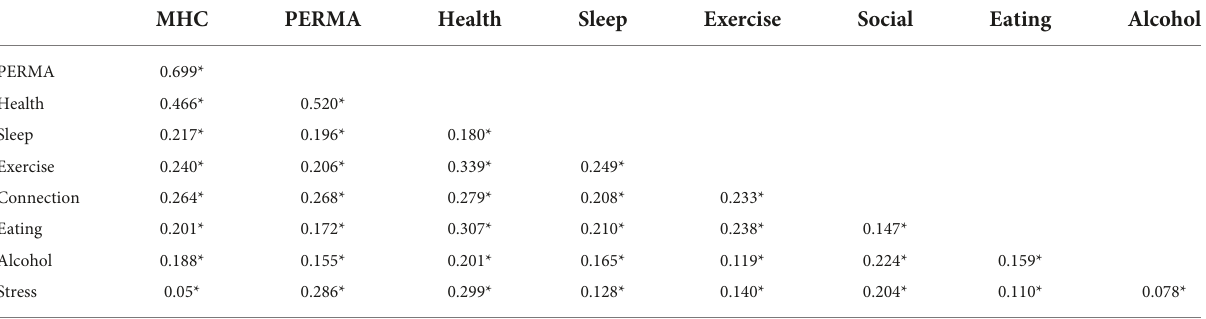
TABLE 2 Pearson correlation between wellbeing measures and the six pillars of lifestyle medicine (LM). MHC PERMA Health Sleep Exercise Social Eating Alcohol